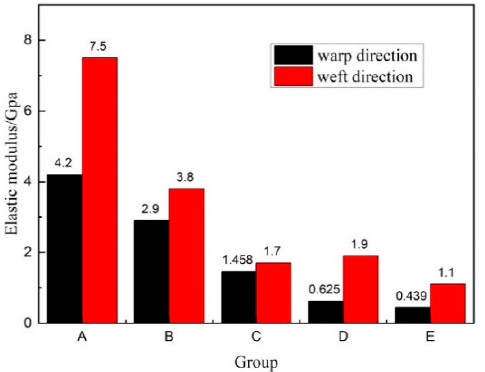
Figure 11. Average elastic modulus in warp and weft directions. As can be seen in Figure 12, the average failure deflection of groups A, B, and C gradually decreased in both the warp and weft directions with the increase in core pile height, while the face sheet thickness was the same. This shows that under the action of uniform load, materials with a large core height fracture faster, while materials with a low core height have better flexibility due to the structure and the effect of the resin matrix. In groups D and E, when the face sheet thickness increased, the samples became more capable of bearing loading head force with more minor fractures. Hence, the bending deflection did not decrease gradually with an increase in core pile height due to the increase in the face sheet thickness. Moreover, the warp direction samples had higher failure deflection than the weft direction samples because the “8” shaped structure in the warp direction had better flexibility than the “1” shaped structure in the weft direction.